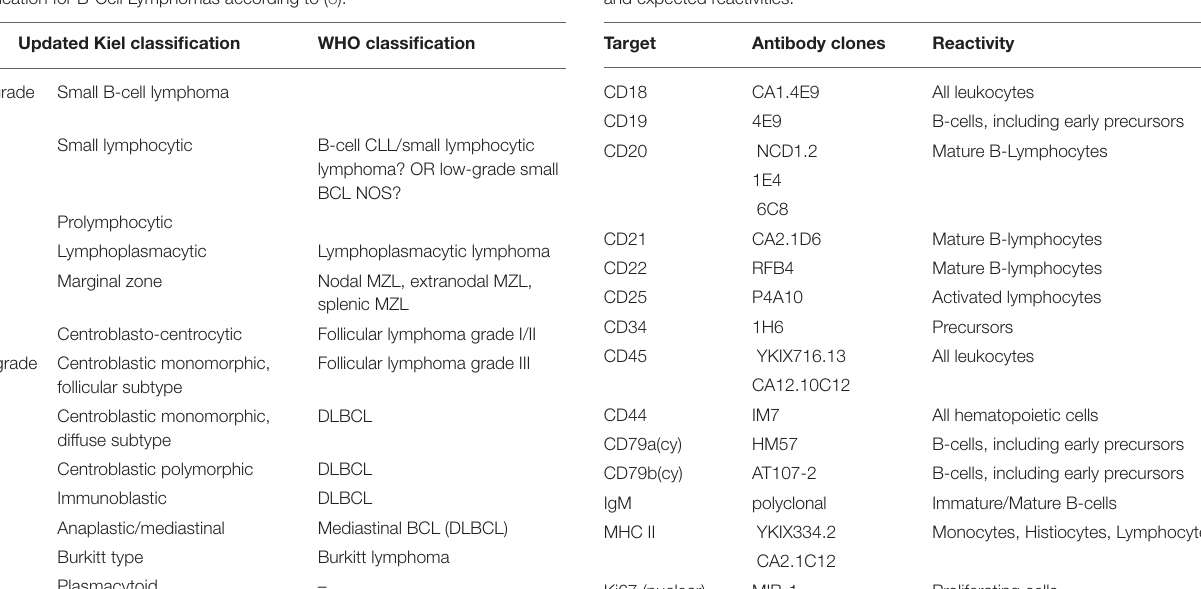
TABLE 2 | Common antibodies used for the characterization of B-cells in dogs and expected